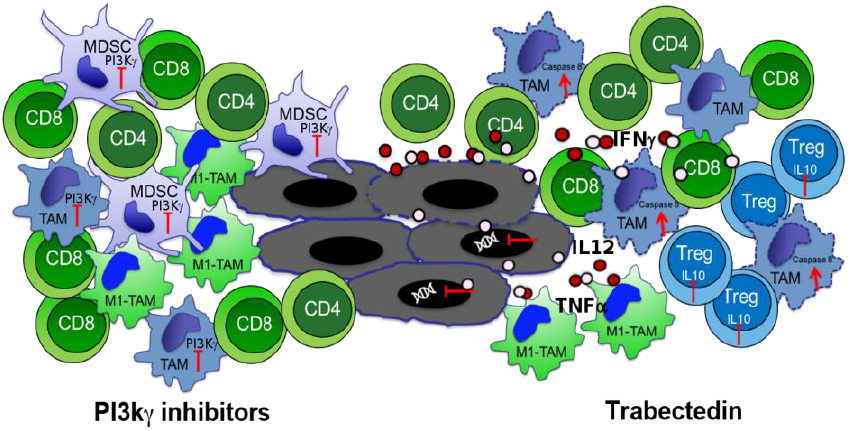
Figure 3. Phosphoinositide 3-Kinaseγ ( PI3Kγ) inhibitor ( left ) and Trabectedin ( right ) effects on immune cells. CD8 recruitment dependent from M1-TAM switch of TAM and MDSC after PI3Kγ inhibition is represented. Caspase-8 activation and cytokine production induced by Trabectedin in TAM, IFNγ production by T cells and IL10 inhibition in Treg are shown.